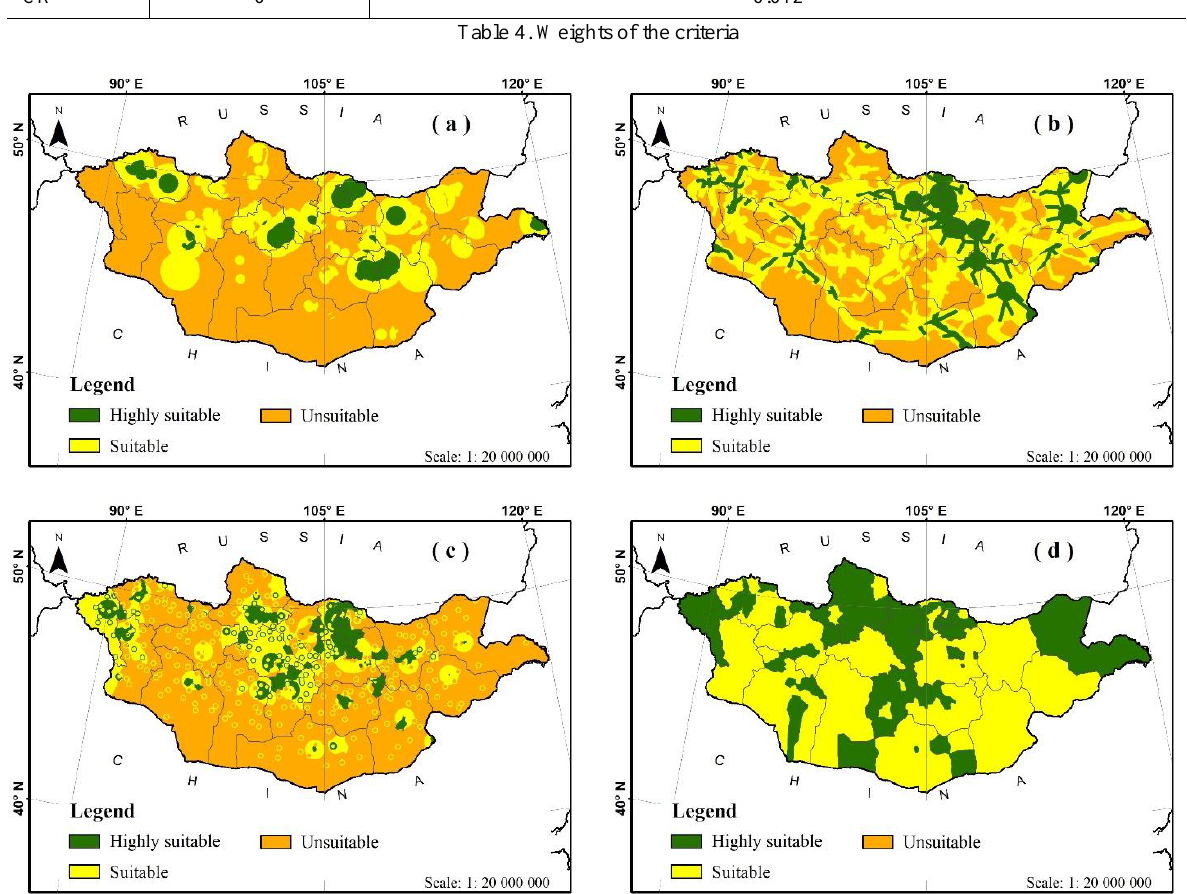
Figure 3. Suitability classification map of criteria (a) factors of mineral resources and natural resources, (b) factors of infrastructure, (c) factors of consumer market, (d) factors of